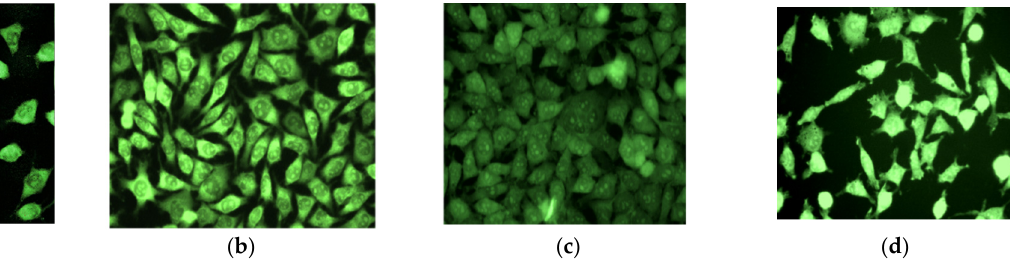
Figure 10. Images of the L929 fibroblast cells growth on the untreated pNIPAAM ( a ); argon ( b ), oxygen ( c ) and ammonia ( d ) plasma-treated pNIPAAM surface.